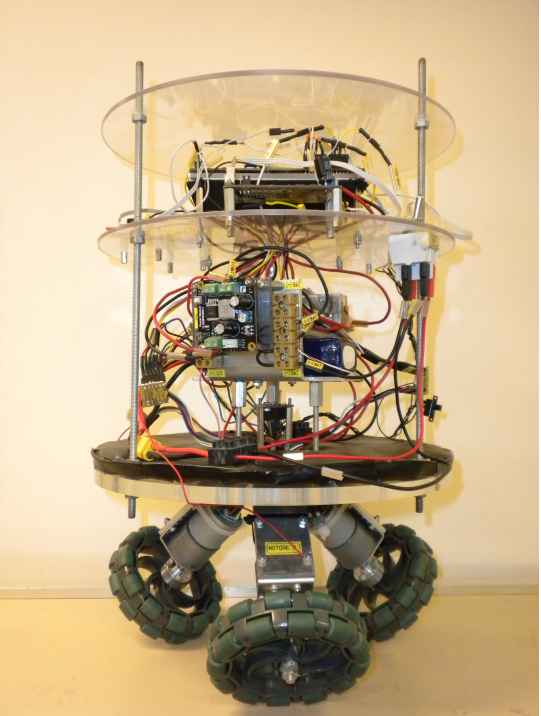
Figure 12. A prototypical three-wheel, small-sized robot for smart-home applications used to perform experiments (from the Department of Information Engineering at the Università Politecnica delle